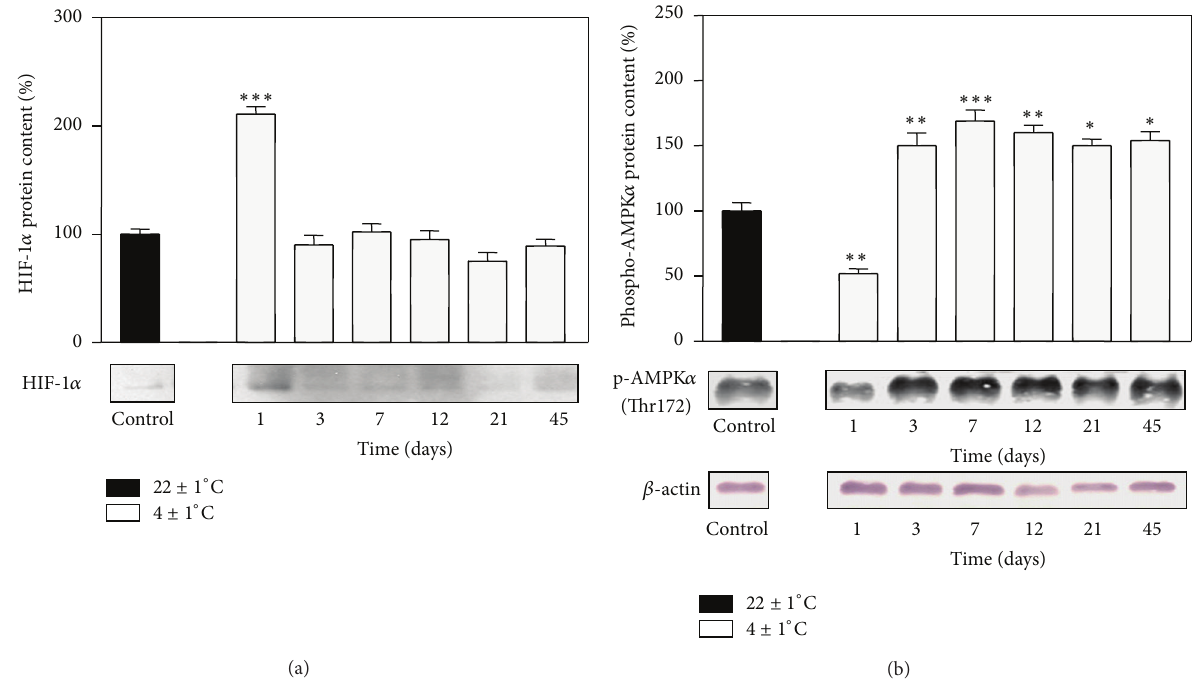
Figure 2: Protein levels of HIF-1 𝛼 (a) and phospho-AMPK 𝛼 (b) in rat RpWAT during cold acclimation. Protein content is expressed relative to a room temperature-acclimated control, which was standardized as 100%. The results of the representative example from three observations are shown. Data were quantified as described in Section 2. The values represent the mean ± S.E.M. ∗ Compared to control, ∗ 𝑃 < 0.05 , ∗∗ 𝑃 < 0.01 , and ∗∗∗ 𝑃 < 0.001